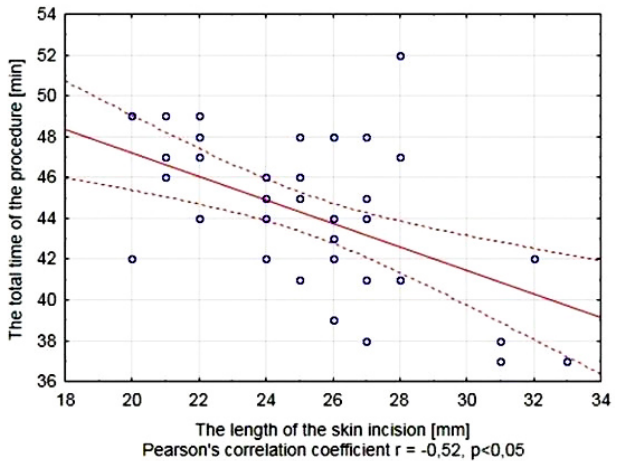
Figure 4. The relationship between the length of the skin incision and the total time of the procedure of bone harvesting from the proximal tibia.